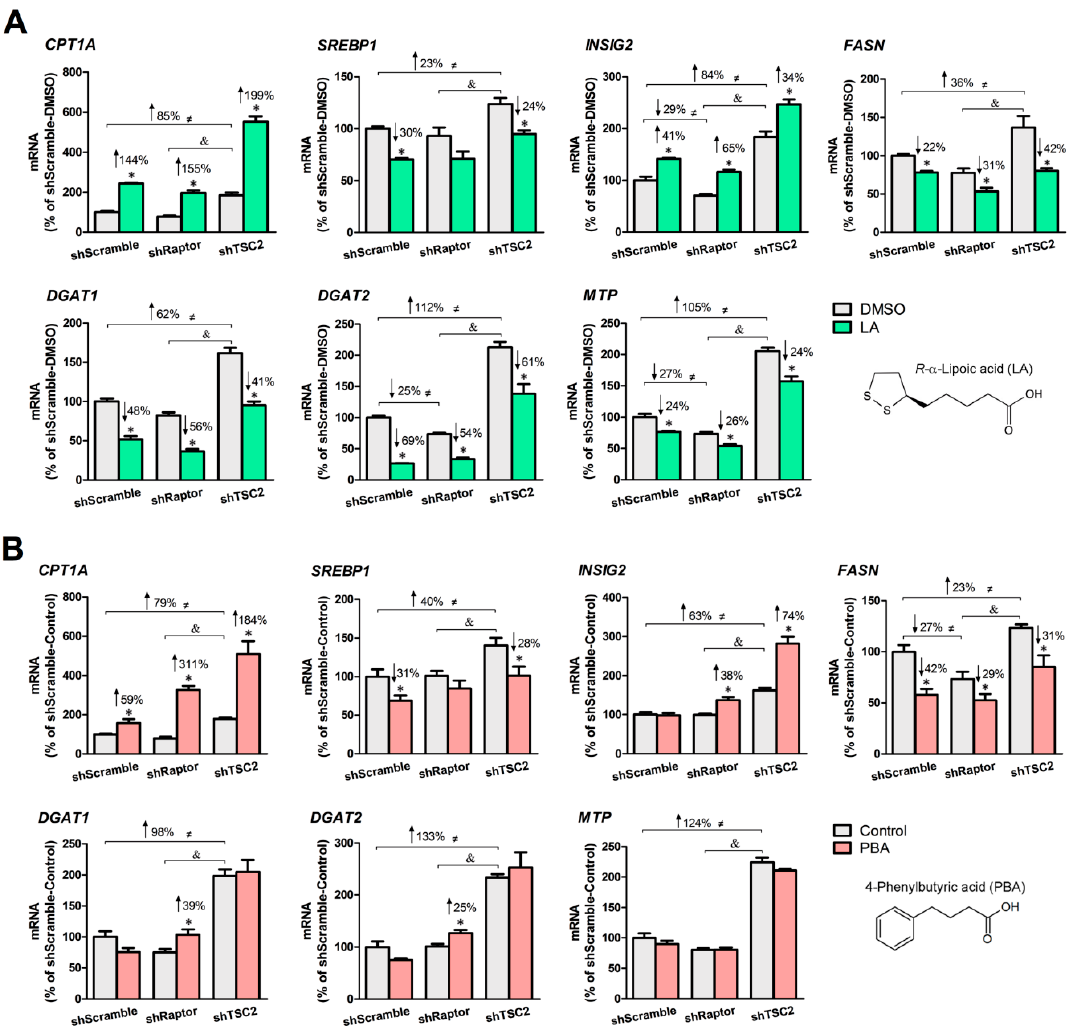
Figure 2. . R - α -lipoic acid (LA) and 4-phenylbutyric acid (PBA) upregulate the expression of lipolysis genes and downregulate that of genes involved in de novo lipogenesis, TAG synthesis and lipoprotein assembly in mTORC1-manipulated HepG2 cells. ( A ) LA (200 µ M, 24 h) significantly stimulated the expression of CPT1A and INSIG2 but decreased that of SREBP1 , FASN , DGAT1 , DGAT2 and MTP . ( B ) PBA (8 mM, 6 h) significantly stimulated the expression of CPT1A and INSIG2 but decreased that of SREBP1 and FASN . * indicates a statistically significant e ff ect of LA or PBA vs. vehicle control within a given stable HepG2 cell line; & indicates a statistically significant e ff ect of shRaptor vs. shTSC2 vehicle control; (cid:44) indicates a statistically significant e ff ect of mTORC1 between stable cell lines; Student’s t -test, p < 0.05, n =